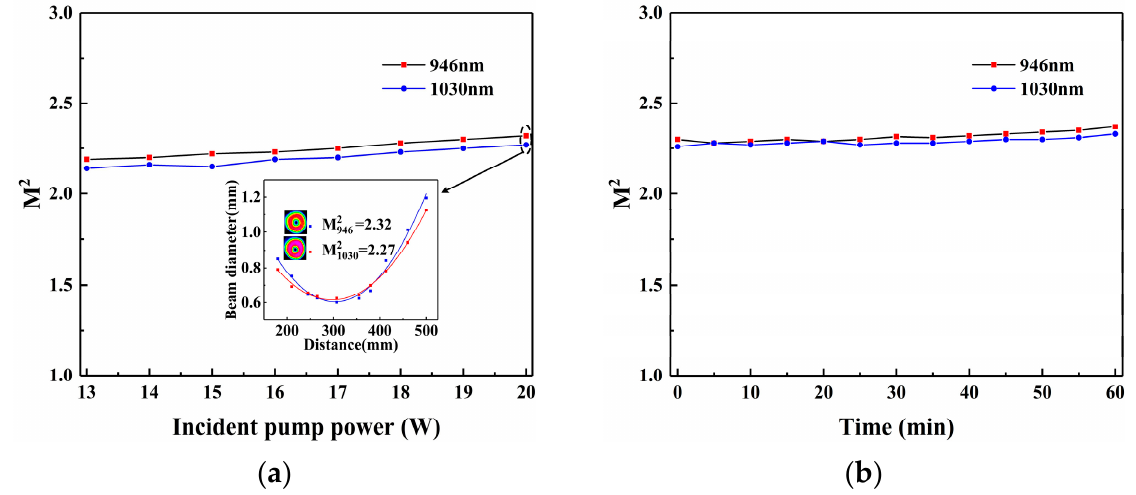
Figure 10. The relationships between the beam quality factors M 2 of the 946/1030 nm LG 01 mode vortex laser and ( a ) pump power and ( b ) time.